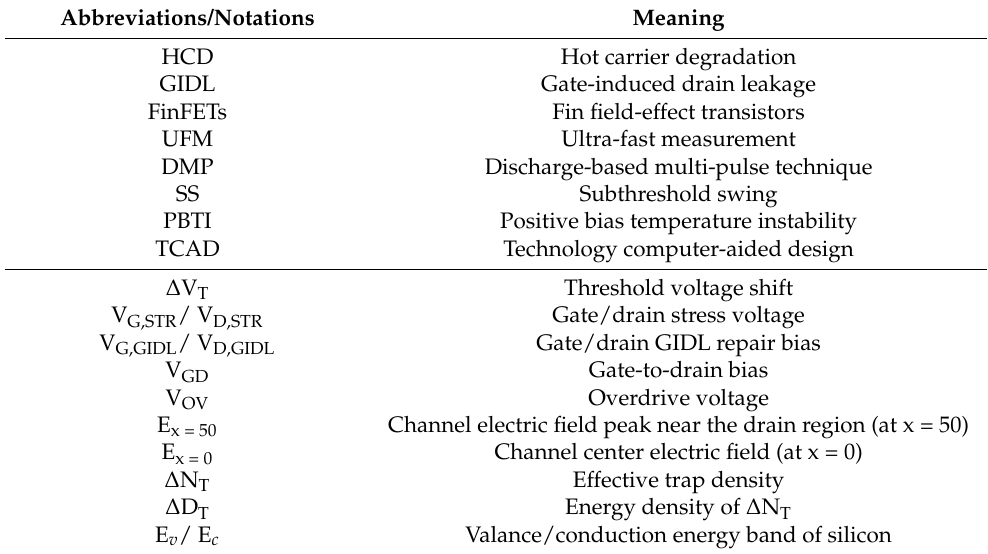
Table 2. List of abbreviations and notations frequently used in this article.